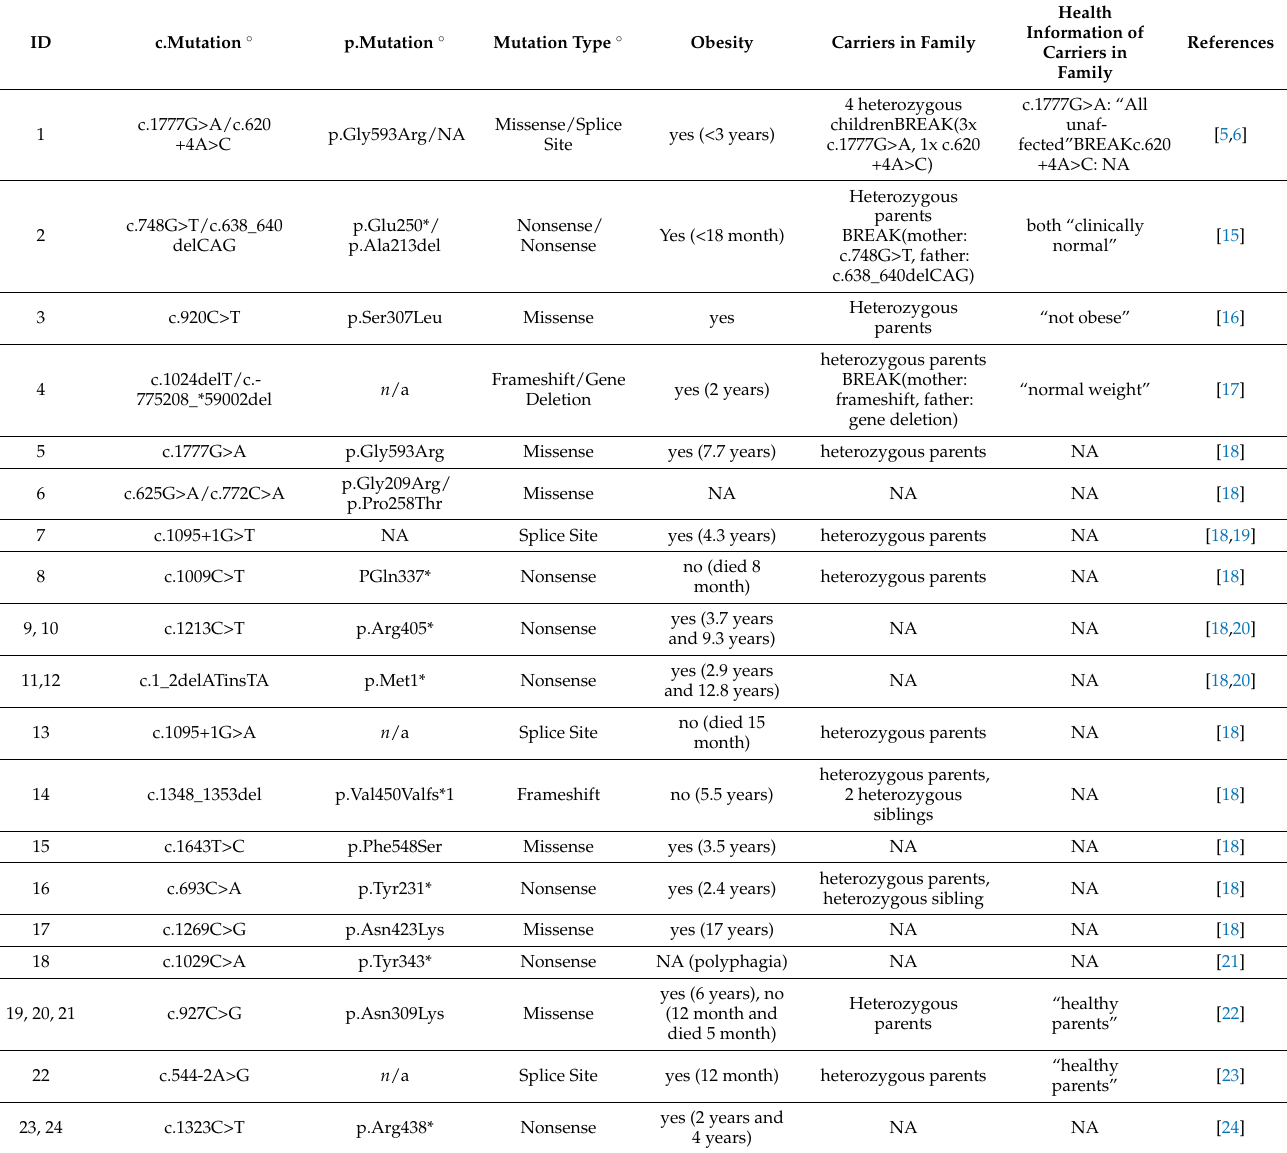
Table 1. Overview of PC1/3 deficiency cases and their carrier relatives. Cases ID 1–25 have been reviewed by and adapted from Pepin et al. [7]. Abbreviations: n /a = not applicable, NA = not assessed, BMI = body mass